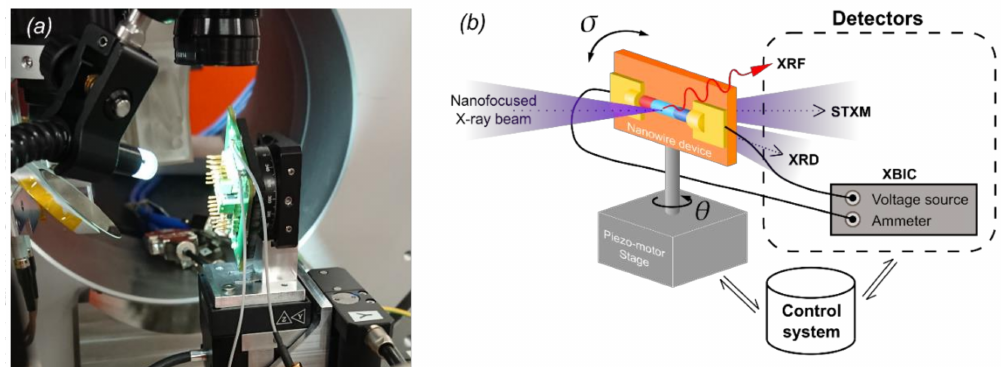
Figure 1. ( a ) Photograph of the installed sample holder on the piezo-motor stage at the NanoMAX beamline. A secured sample on the sample holder is installed on the piezo-motor stage. The tilted mirror to the left of the sample is the 45-degree mirror for the downstream optical microscope used to locate a particular nanowire device on the sample. ( b ) Schematic of the experimental setup at the end-station of NanoMAX. The sample was mounted on the piezo-motor stage, which can be moved in three dimensions and rotated about the vertical axis with the angle θ . Four measurement modes, X-ray fluorescence (XRF), Scanning transmission X-ray microscopy (STXM), X-ray di ff raction